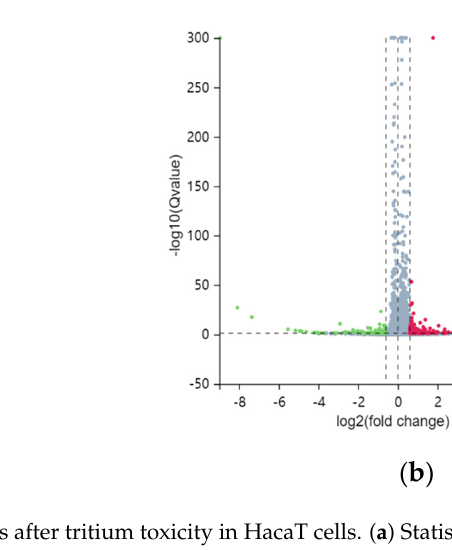
Figure 2. Pearson correlation heap map. The Pearson correlation coefficient is reflected in the form of a heat map. The correlation coefficient can reflect the similarity of the overall gene expression among all samples. The higher the correlation coefficient, the more similar the gene expression level is. The closer the correlation coefficient is to 1, the higher the similarity of expression patterns between DZ (DZ1, DZ2 and DZ3) and GJL (GJL1, GJL2 and GJL3) samples.